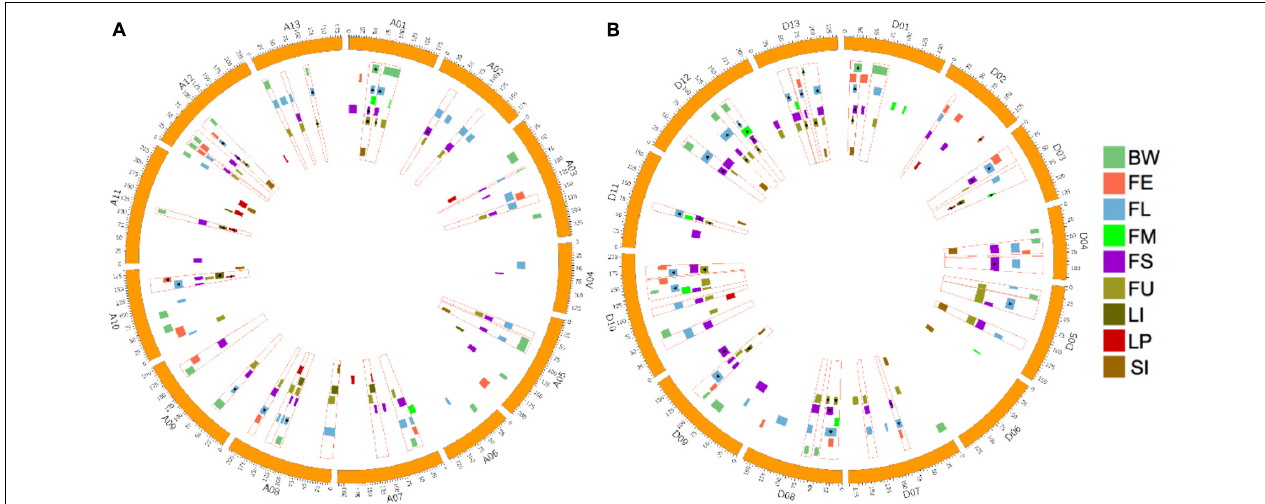
FIGURE 3 | Distribution of QTLs for fiber quality and yield related traits and QTL clusters in the genetic map. (A) Distribution of QTLs and QTL clusters in the At subgenome. (B) Distribution of QTLs and QTL clusters in the Dt subgenome. The red rectangular frame indicating QTL clusters. The highlight rectangle indicating the confidence interval of each QTL, and the triangle indicating that the QTL is stable across environments.